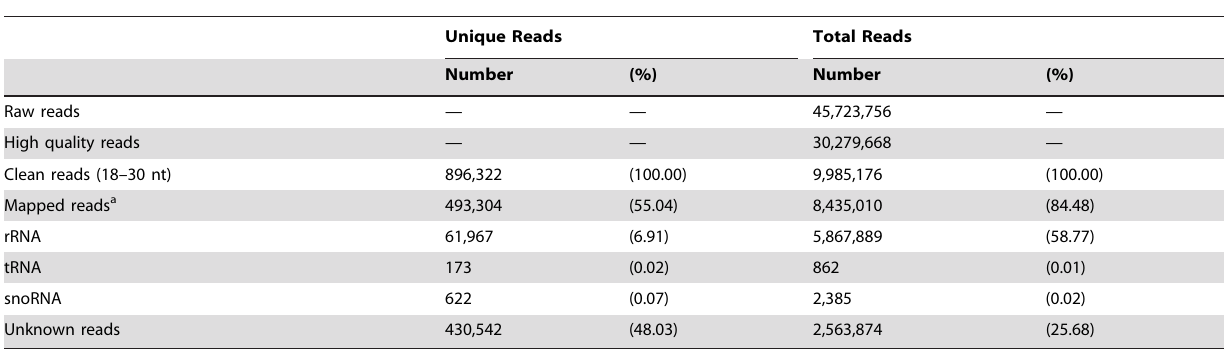
Table 1. Composition of the small RNA